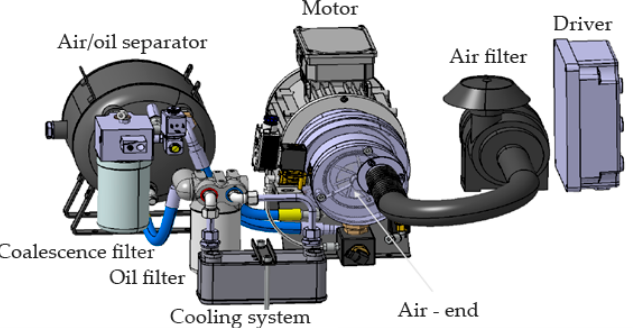
Figure 1. Schematic of the first prototype of the air compressor unit designed specifically for electric and electrified heavy-duty vehicles and tested inside a climatic chamber in the present work.